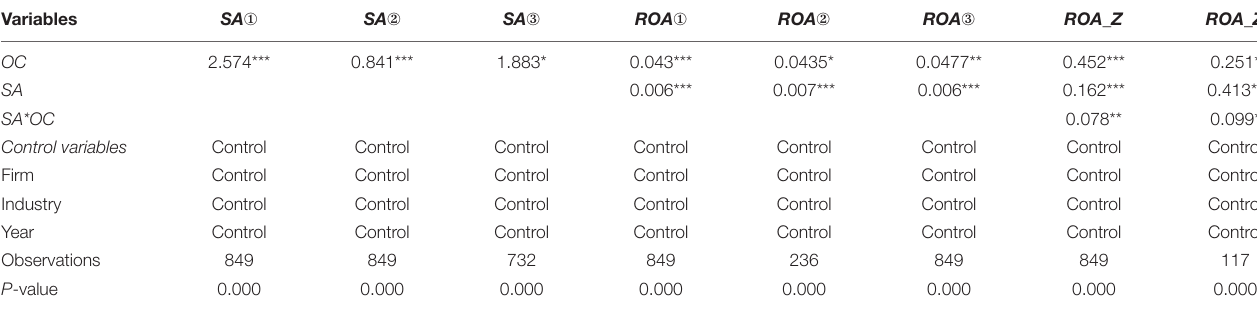
TABLE 10 | Robustness test